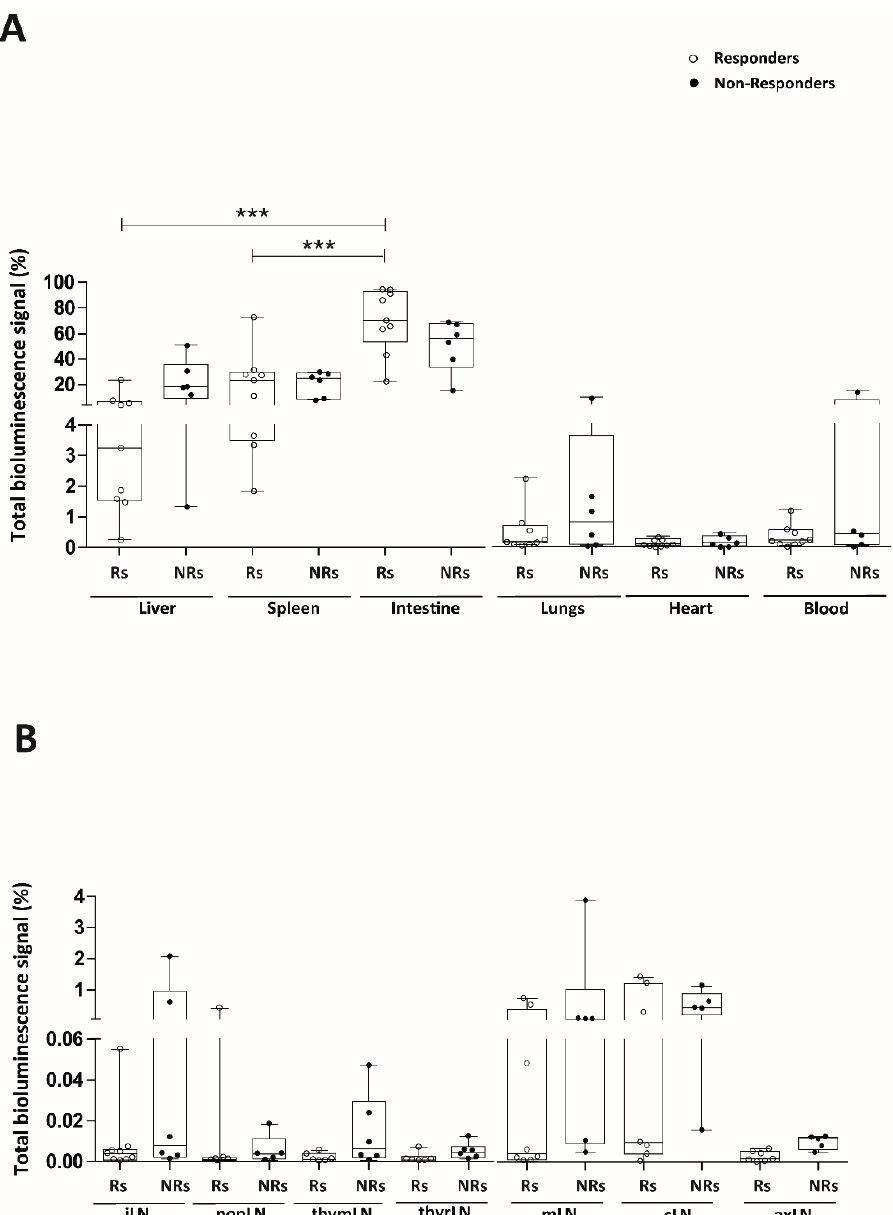
Figure 5. Analysis of the bioluminescence signal in the different tissues and organs (liver, spleen, intestine, lungs, heart and blood) and in the different lymph nodes (inguinal, popliteal, parathymic, parathyroid, mesenteric, caudal and axillary) at 48 h in “ responder ” and “ non-responder ” TNBS-colitic mice. ( A ) Bioluminescence signals, measured at 48 h, in the liver, spleen, intestine, lungs, heart and blood and in the inguinal (iLN), popliteal (popLN), parathymic (thymLN), parathyroid (thyrLN), mesenteric (mLN), caudal (cLN) and axillary (axLN) LNs. ( B ) in “ responders ” (did not lose weight at 48 h with respect to 24 h) and “ non-responders ” (lost weight at 48 h with respect to 24 h) were analyzed as percentage of light units per tissue relative to the total number of light units per mouse. TNBS + Luci-eASCs Rs, ( n = 9); TNBS + Luci-eASCs NRs, ( n = 6). Data are presented by dots and box-plots that represent the interquartile range (p75, upper edge; p25, lower edge; p50, midline; p95, line above the box, and p5, line below the box) of the percentage of total bioluminescence signal. Significance was analyzed by the Mann-Whitney U test represented by *** p < 0.001. Results correspond to four independent experiments.